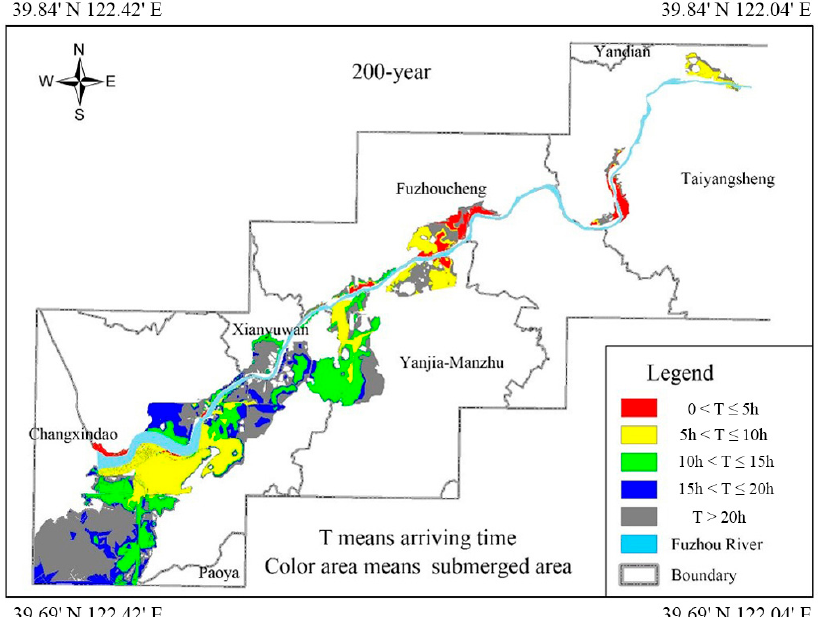
Figure 14. Flood arrival time and submerged area of 200-year return period scenario.